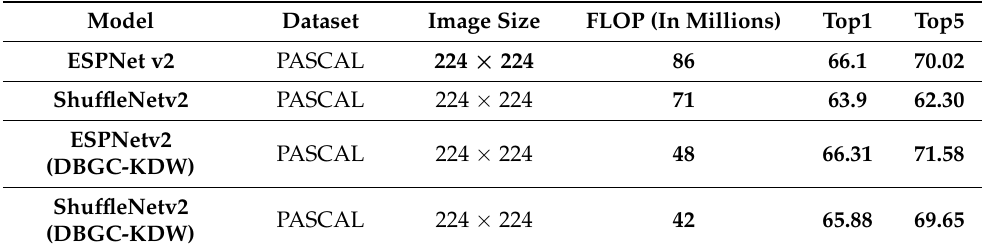
Table 6. Depth + width-based kernel. Table 6. Depth+width-based kernel.